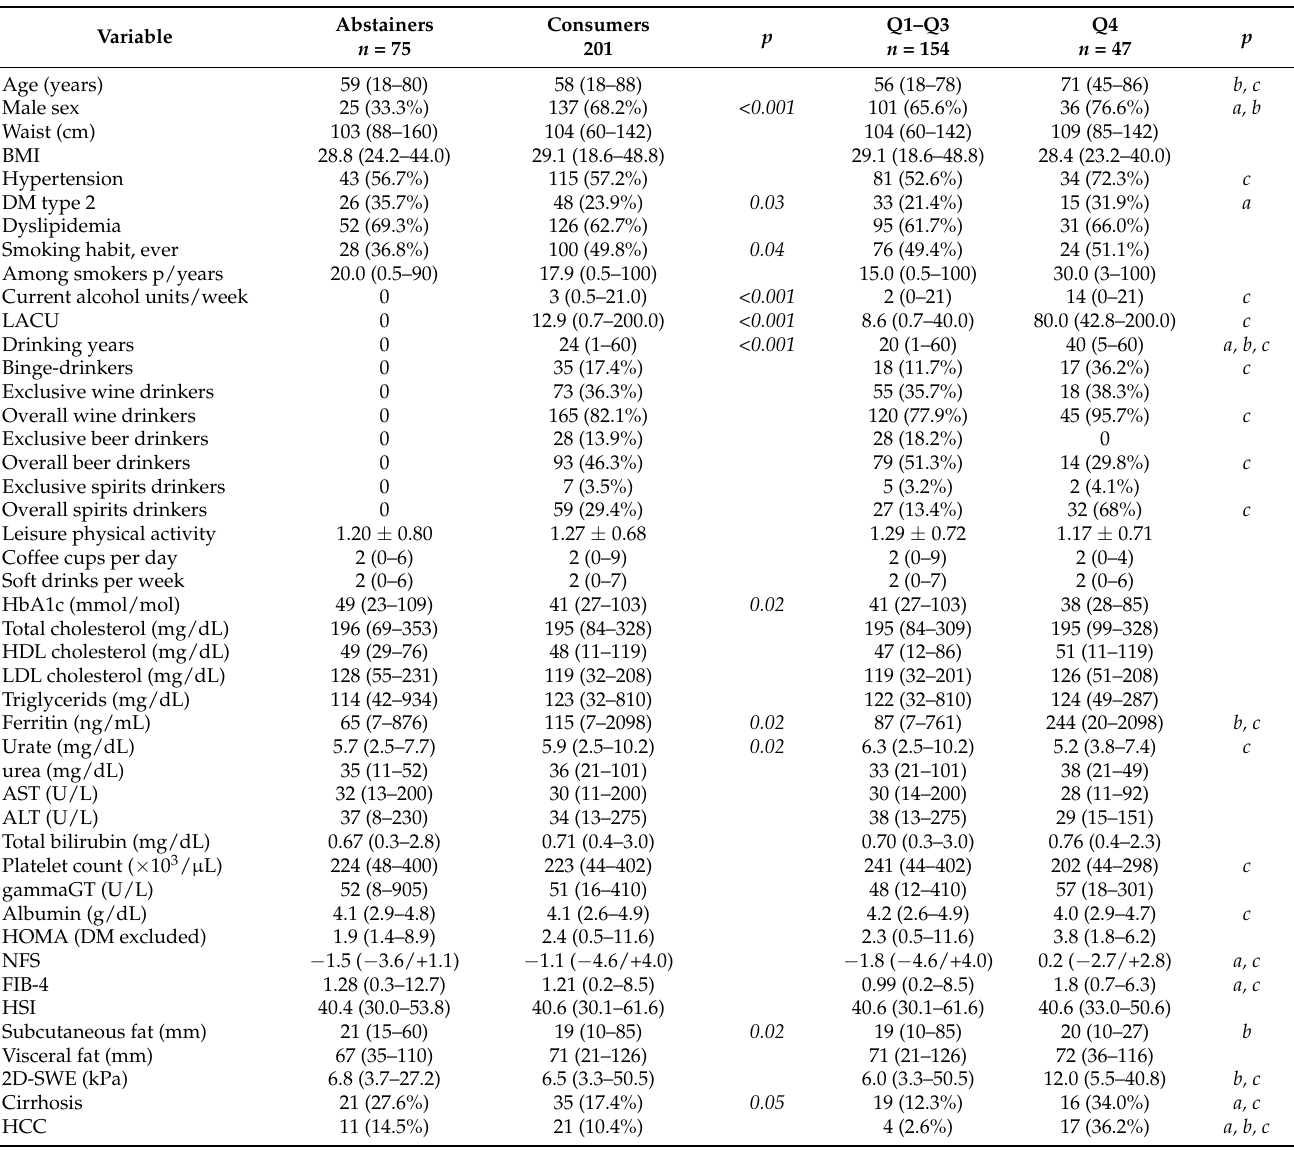
Table 3. Patient characteristics according to lifetime alcohol exposure (LACU). LACU